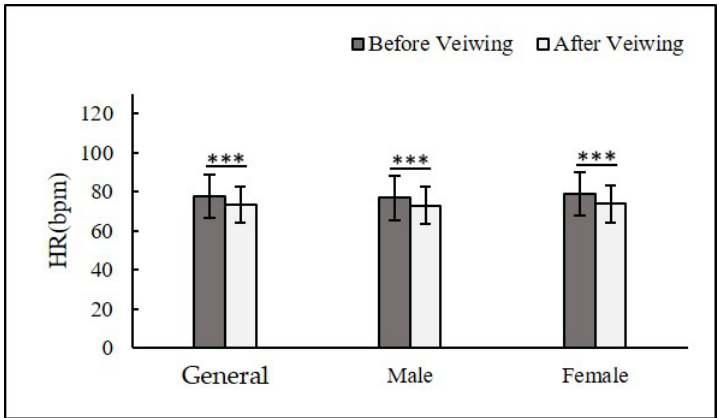
Figure 5. Changes in heart rate before and after viewing the landscape forest pictures (n = 120; mean ± SD; * p < 0.05; ** p < 0.01; *** p < 0.001; verified by a paired t-test).